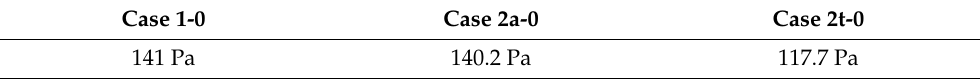
Table 5. The pressure losses of the RECs with different baffle configurations.